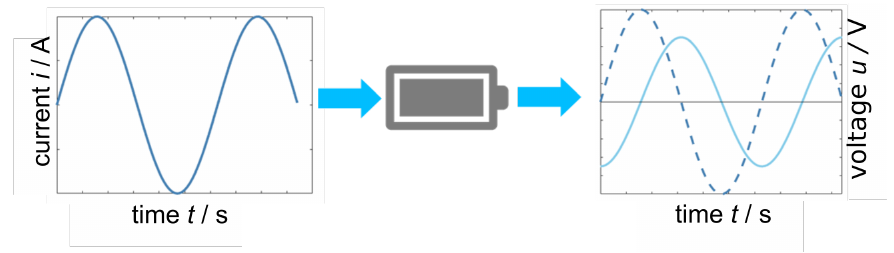
Figure 3. Schematic figure of a sinusoidal current excitation and the voltage response of the system with the phase